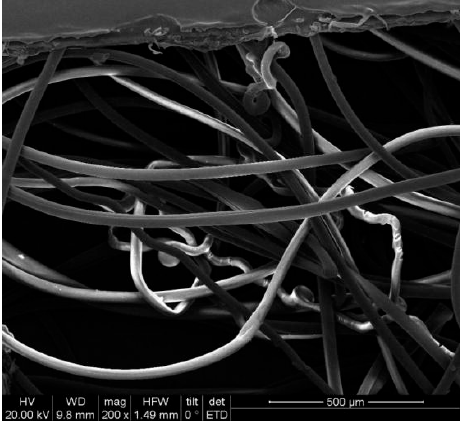
Figure 1. SEM image of the carrier.